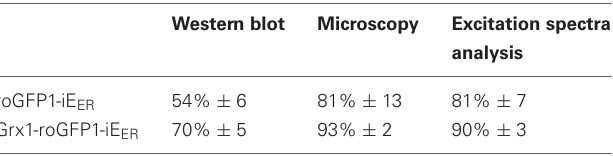
Table 1 | OxD values (percentage ± s.d.) of roGFP1-iE ER and Grx1-roGFP-iE ER obtained by different